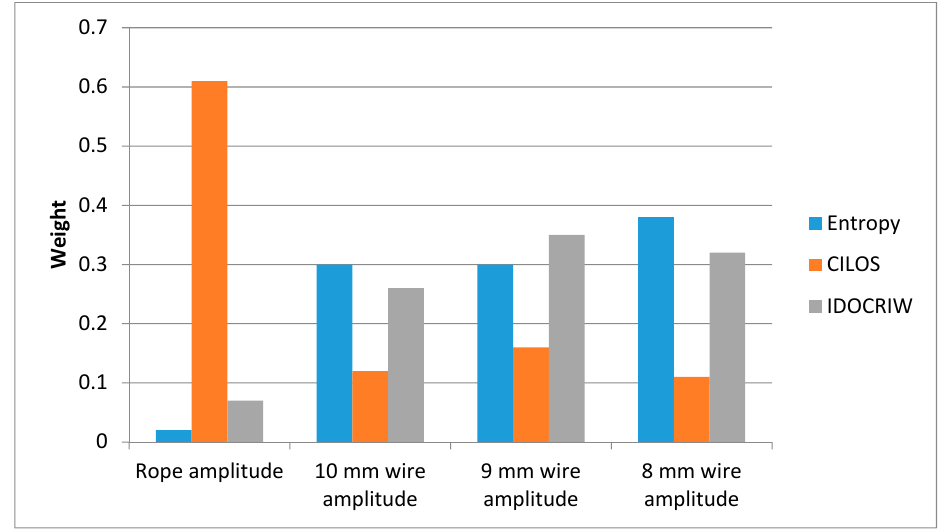
Figure 6. Results of the criteria weight distribution for entropy, CILOS and IDOCRIW methods for a 110 Hz vibration frequency.